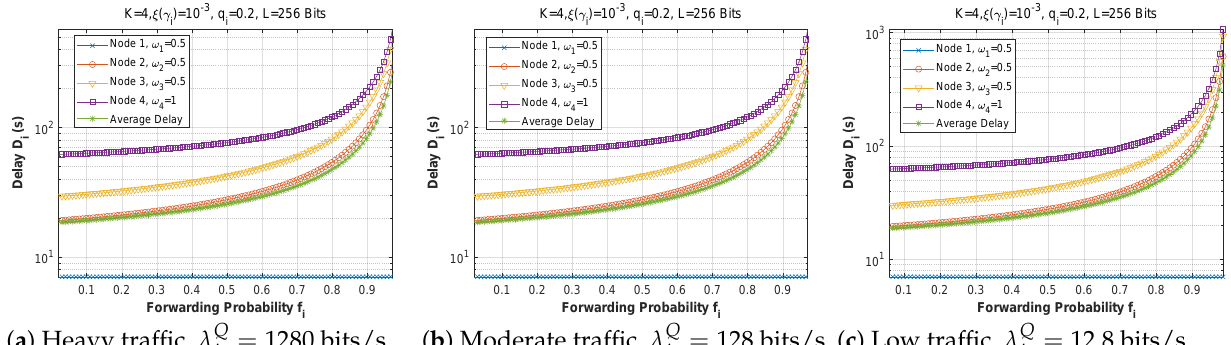
Figure 9. Setting 1: The delay experienced at each mobile device when varying the forwarding probability with the arrival rate λ Q i